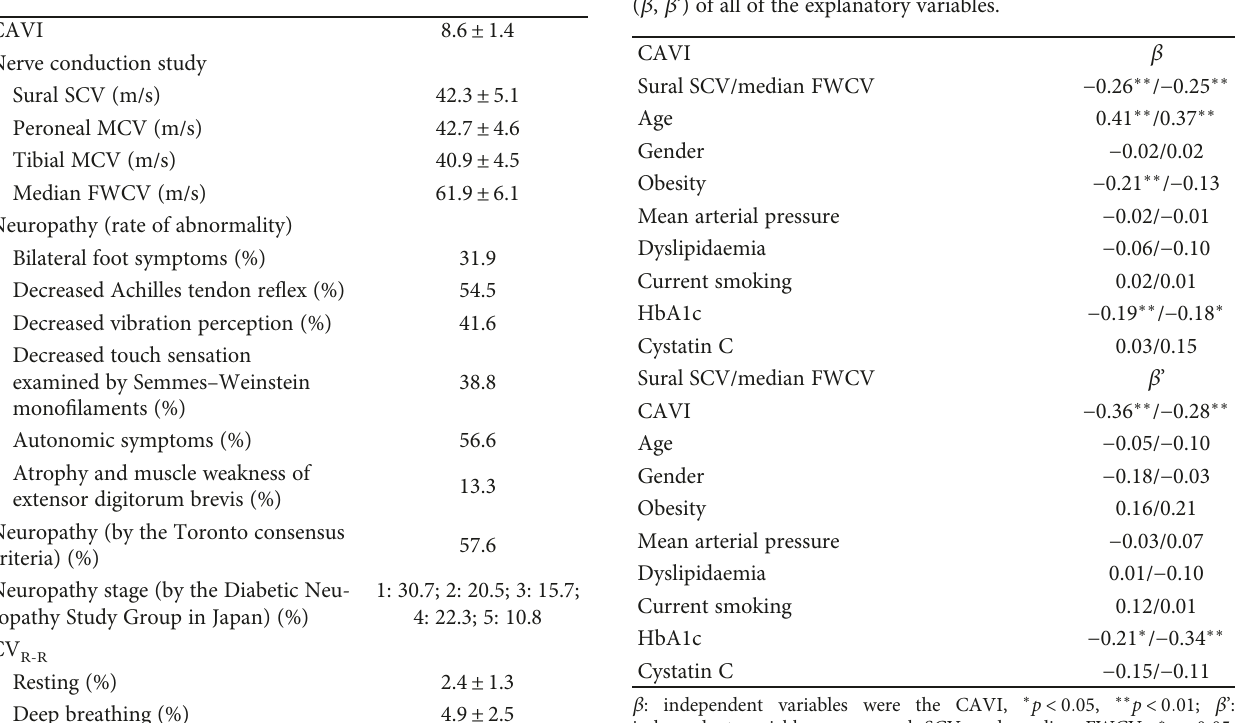
Table 3: Simple and multiple linear regression analyses of indices of diabetic neuropathy with the CAVI.